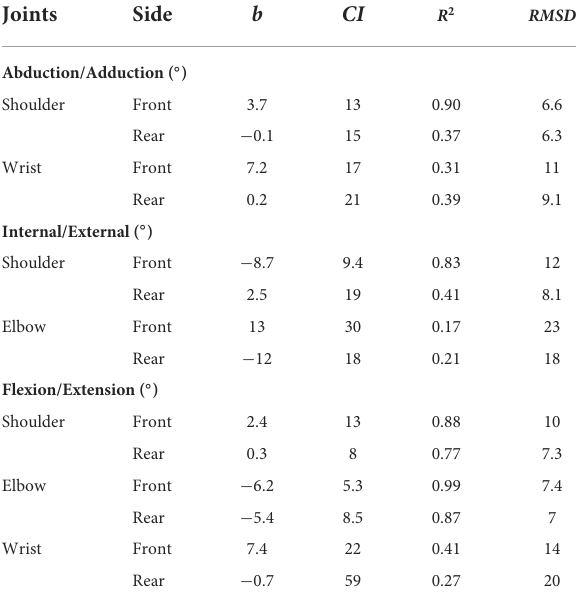
TABLE 3 Bland–Altman bias ( b ), confidence interval ( CI ) along with coefficient of determination ( R 2 ) and root mean square difference ( RMSD ) between markerless and marker-based methods for joint angles at the shoulder, elbow, and wrist.